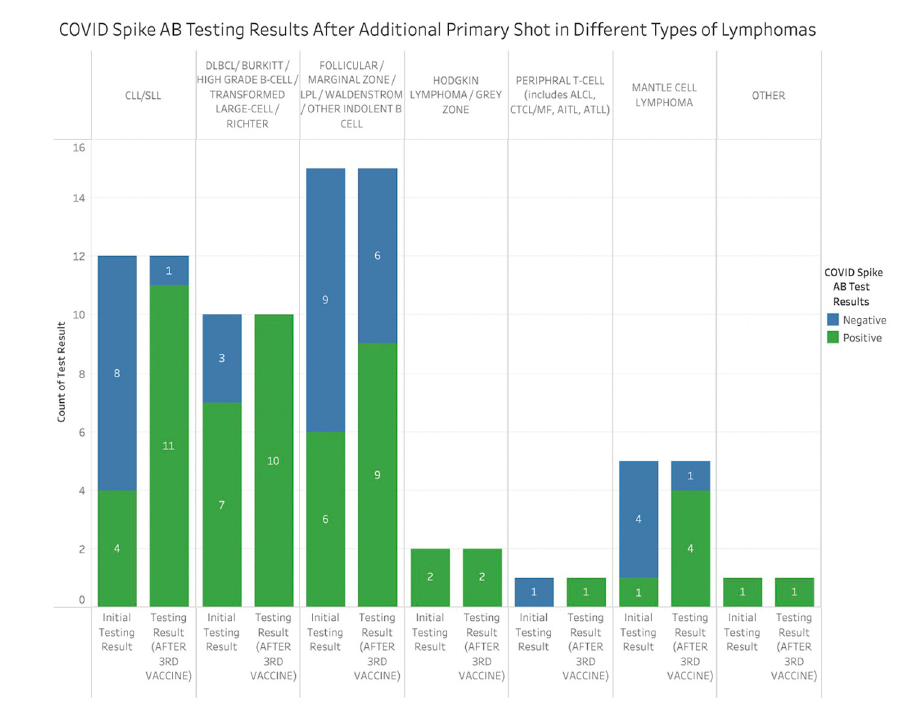
Fig 3. Serologic response against COVID spike protein after additional primary shot by lymphoma diagnosis.